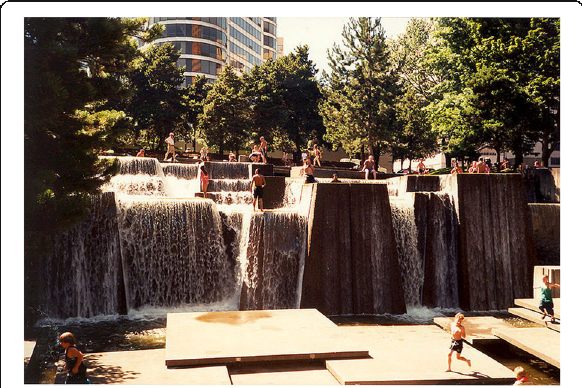
Fig. 8 The Ira Keller Fountain, Portland Oregon. According to Pallasmaa (2011), p. 596) this is “ An architecture for all the